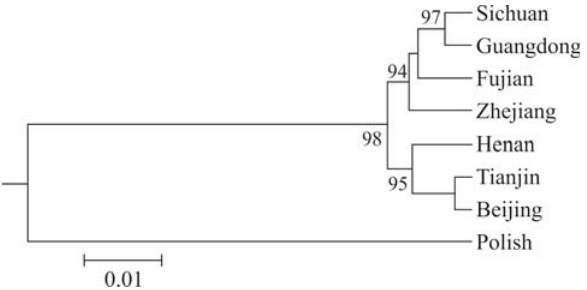
Figure 2 - Genetic affinities between seven Chinese populations based on 13 STR loci by DA distance and UPGMA clustering